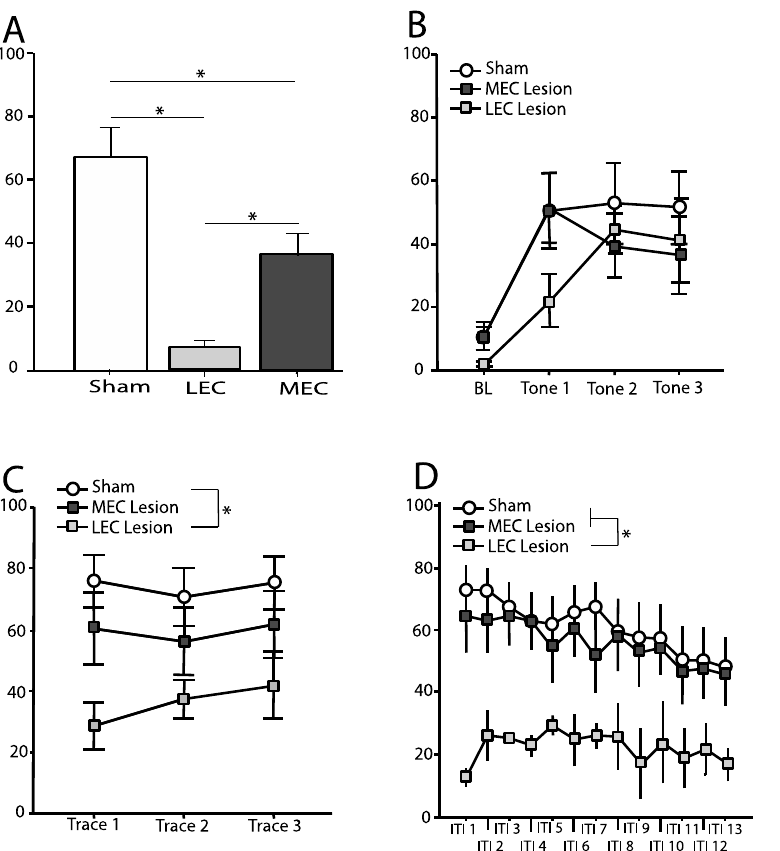
Figure 3. Mean (±SEM) percentage time spent freezing during the context test and tone test for rats trained using trace conditioning . ( A ) Freezing during the entire 8-min context test. Both lesion groups show a deficit in freezing to context compared to controls. Additionally, LEC lesioned rats froze significantly less than MEC lesioned rats. ( B ) Baseline (BL) freezing taking place during the first 180 s of the tone test, prior to presentation of the first tone as well as freezing during each 16-s tone presentation. ( C ) Freezing during the 28-s trace interval following each tone presentation. LEC lesioned rats froze significantly less compared to control rats. ( D ) Freezing during each 212 s period following each trace interval divided into 16-s bins (with bin 13 being 20 s). LEC lesioned rats froze significantly less compared to both control rats and MEC lesioned rats. * indicates statistically significant group